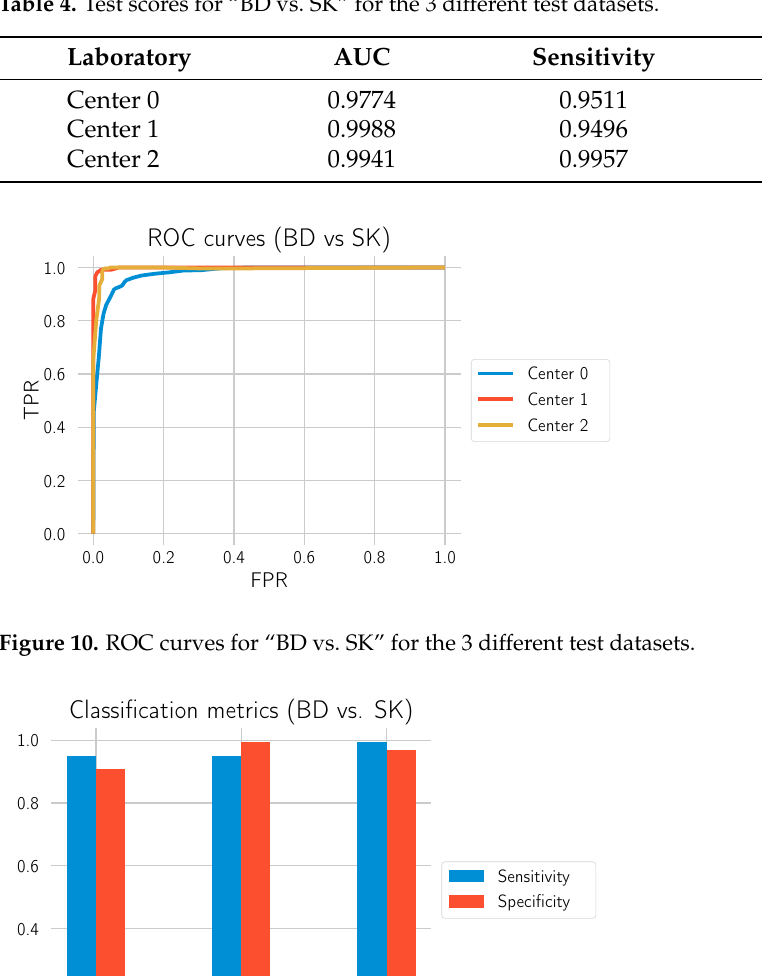
Table 4. Test scores for “BD vs. SK” for the 3 different test datasets.